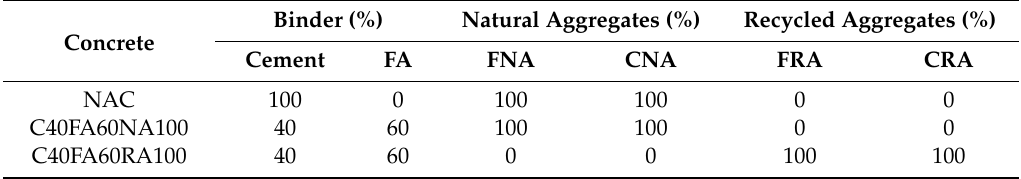
Table 3. Concrete mix